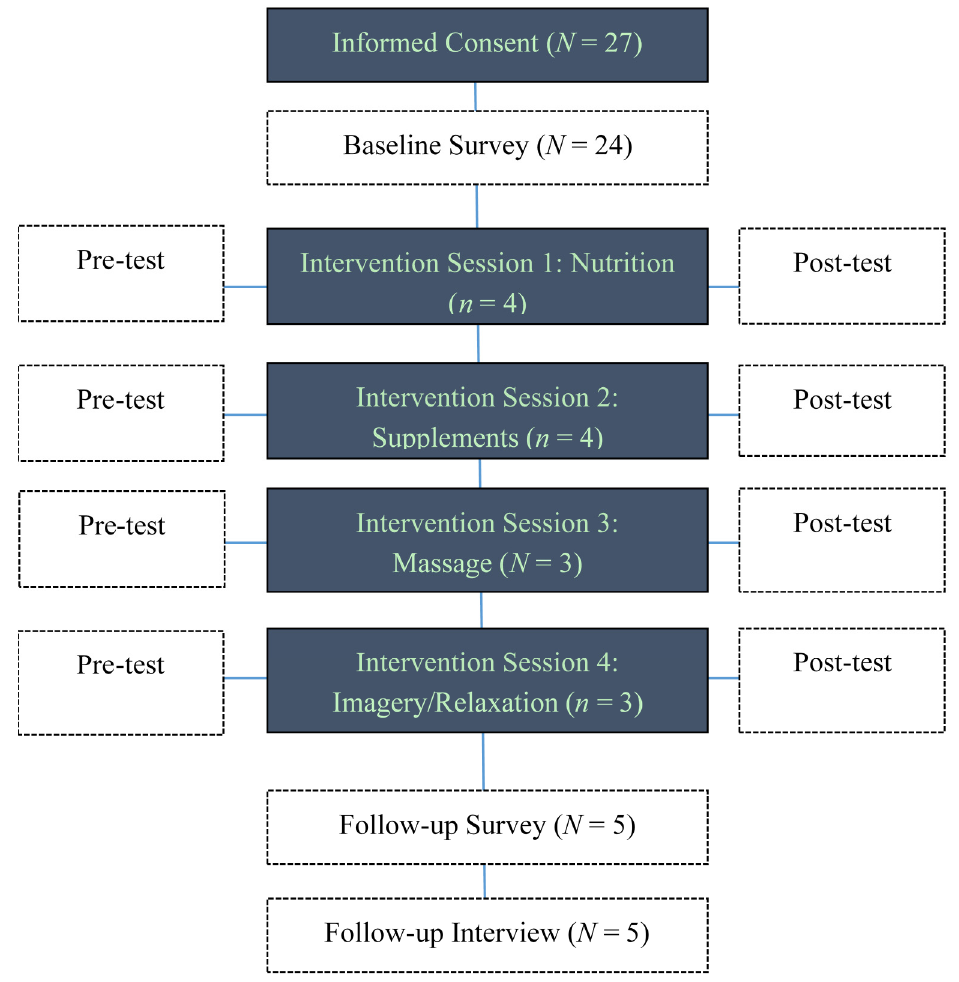
Figure 2. Intervention